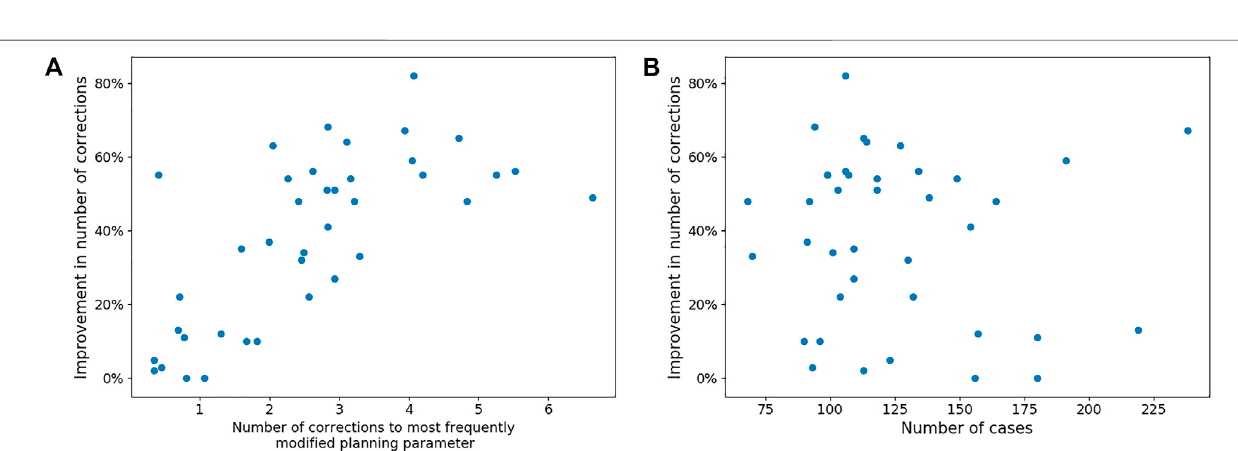
FIGURE 6 | Panel (A) shows the trend between the number of corrections made to the most frequently modi fi ed planning parameter in the MPP of each surgeon and the reduction in corrections needed to the best ML-based plan. Panel (B) shows the lack of a trend between the number of cases available per surgeon and the improvement that can be made with ML-based